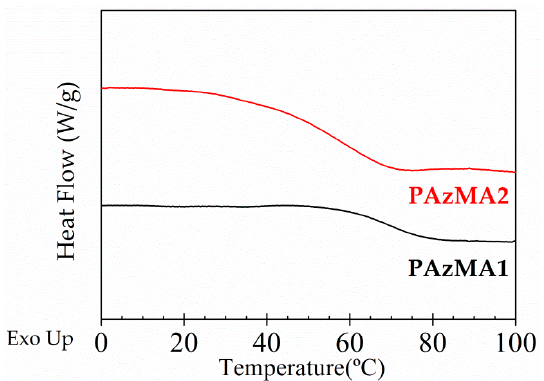
Figure 5. DSC experimental curves for PAzMa1 (bottom) and PAzMa2 (above) samples.